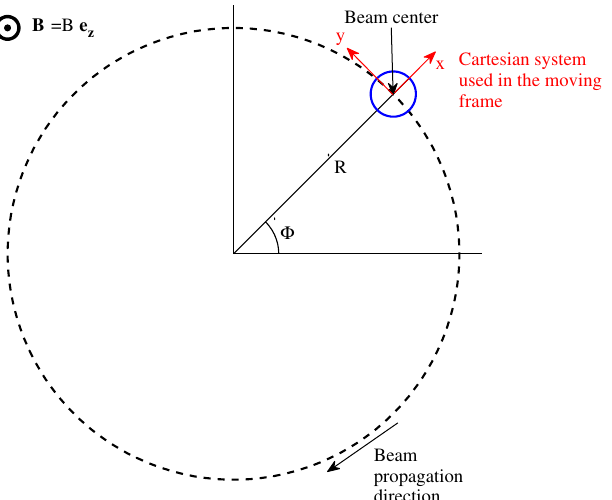
FIG. 1. Polar coordinates ð R; (cid:1) Þ used to define the change of reference frame to the frame rotating with the beam, and (in red) Cartesian coordinate system used in the rotating frame.